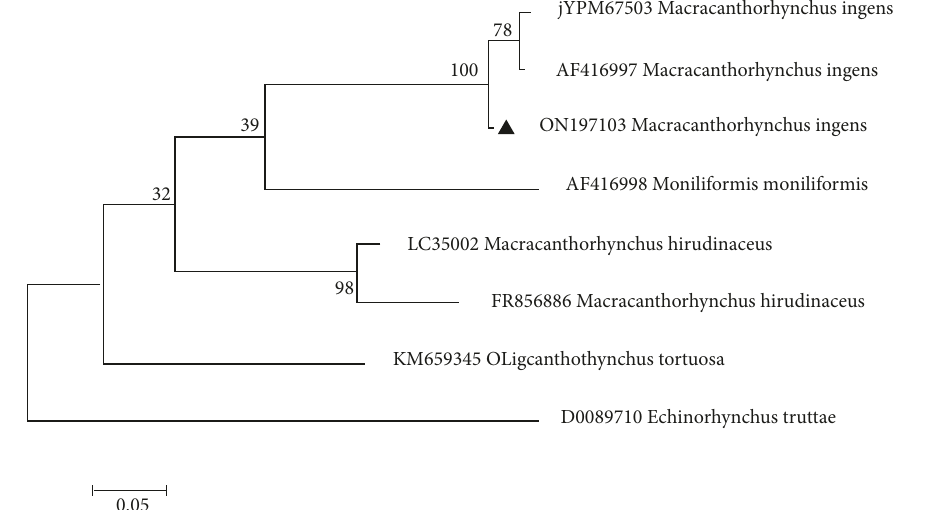
Figure 3: Phylogenetic analysis of isolate of M. ingens obtained in this study ( ▲ ) and closest-related members of class Archiacanthocephala retrieved from GenBank based on partial cox1 gene. Echinorhynchustruttae sequence was used as the out-group. The scale bar indicates the expected number of substitutions per site.